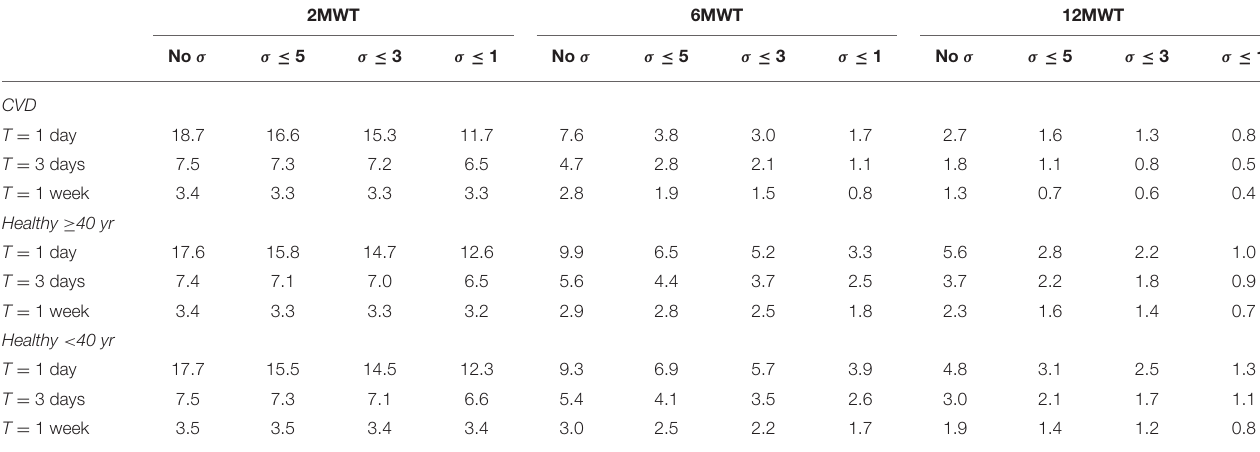
TABLE 3 | The average number of detected walk tests in free-living activities for different analysis time intervals T and cadence variations σ .